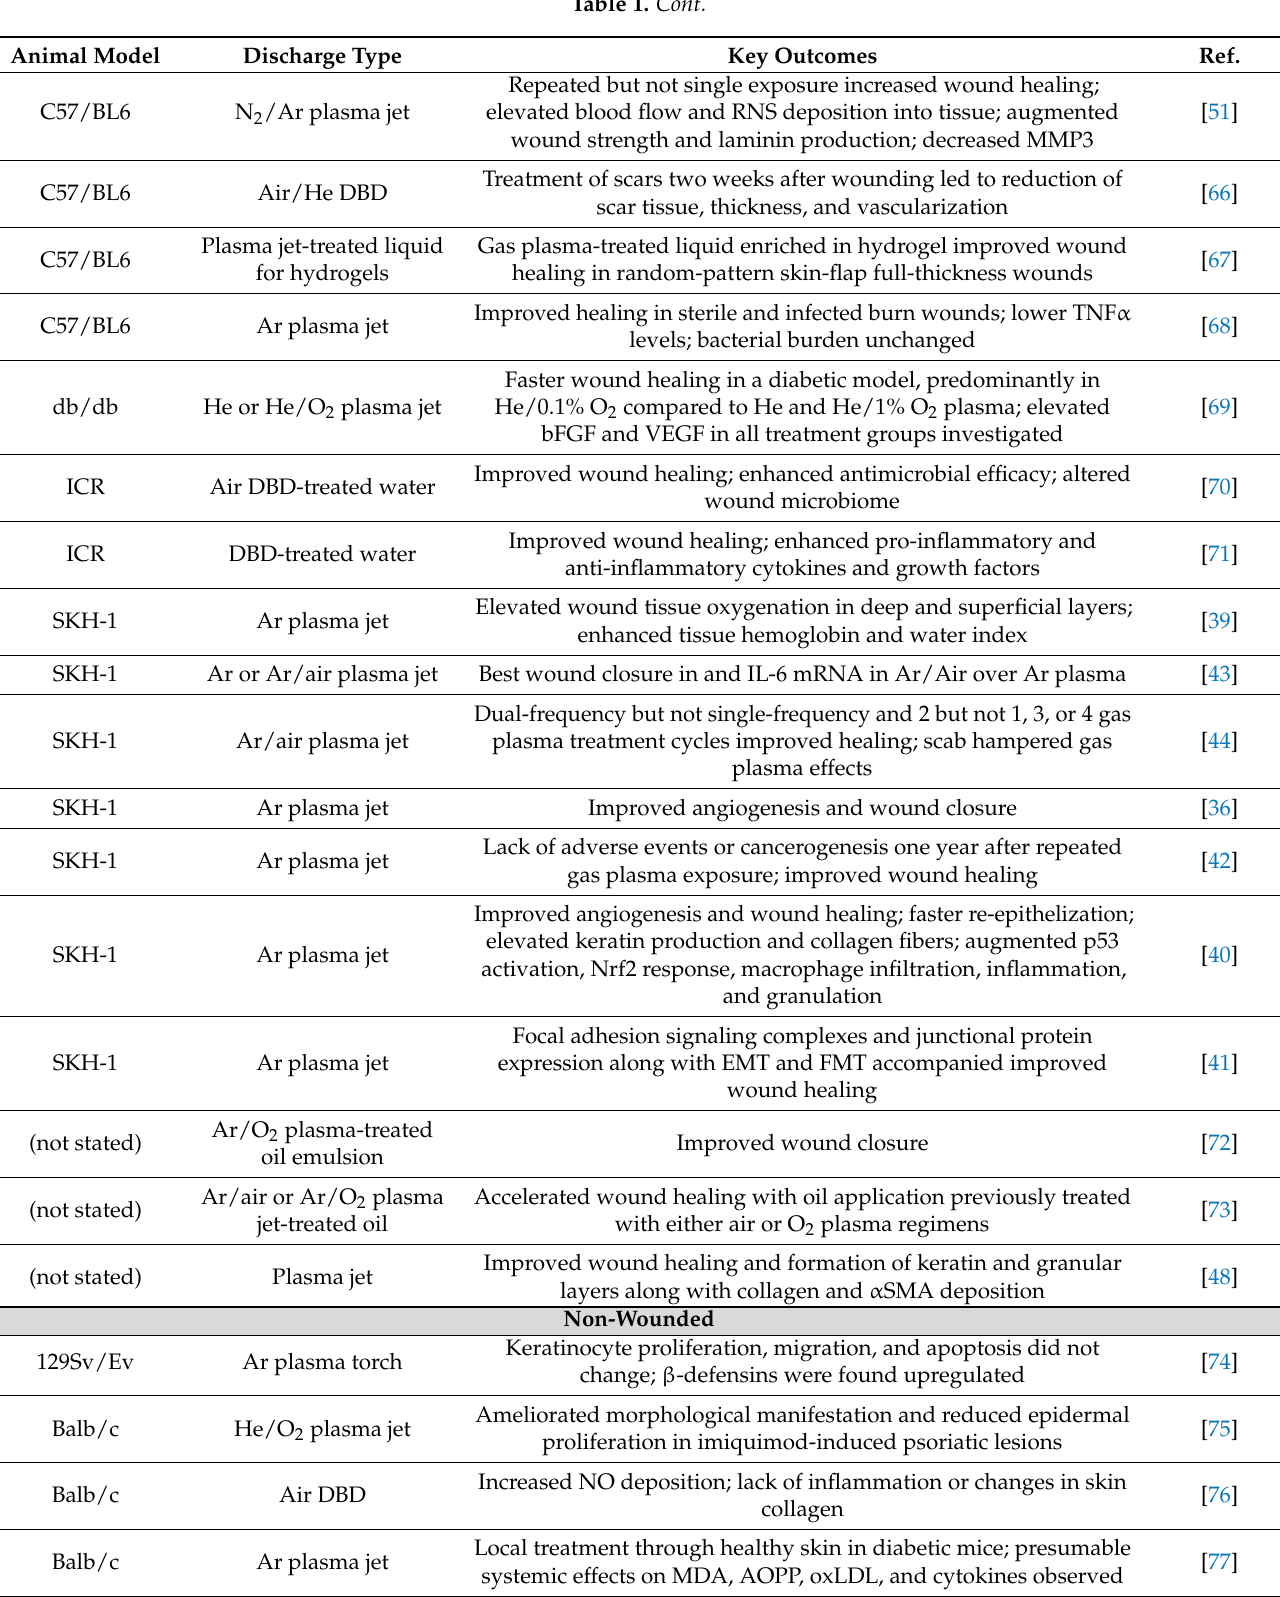
Table 1. Cont. Key Outcomes